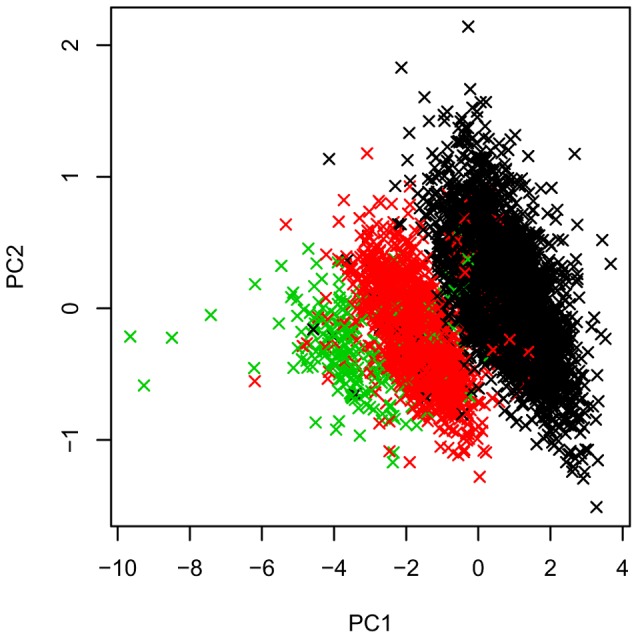
Decomposition of multi-probe CNV data at the INS VNTR locus into first two principal components PC1 and PC2.Principal components PC1 and PC2 summarize the multi-probe CNV data at the INS VNTR locus. Colors (green/red/black) were chosen based on the genotypes of the SNP rs689 (AA/AT/TT), which captures the class I-class III separation.